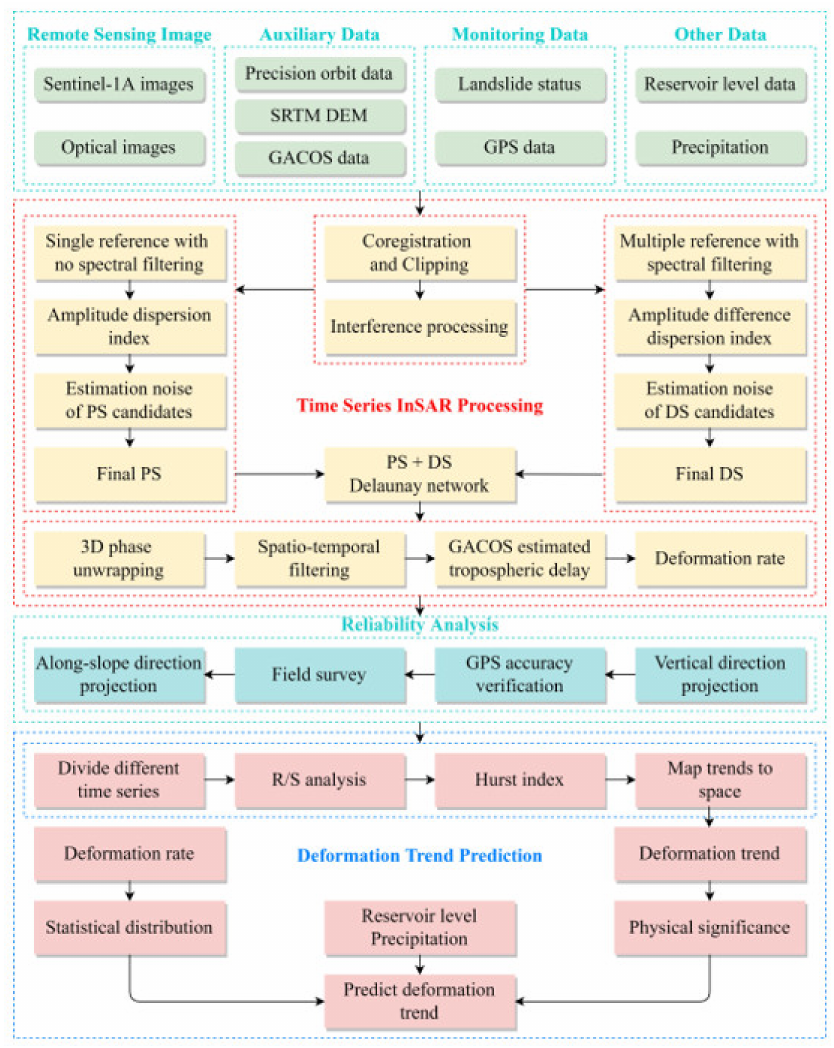
Figure 4. The flowchart of landslide deformation monitoring and trend prediction. SRTM DEM: Shuttle Radar Topography Mission Digital Elevation Model; GACOS: Generic Atmospheric Correction Online Service for InSAR; GPS: Global Position System; InSAR: Interferometric Synthetic Aperture Radar; PS: Persistent Scatterer; DS: Distributed Scatterer; R/S: Rescaled